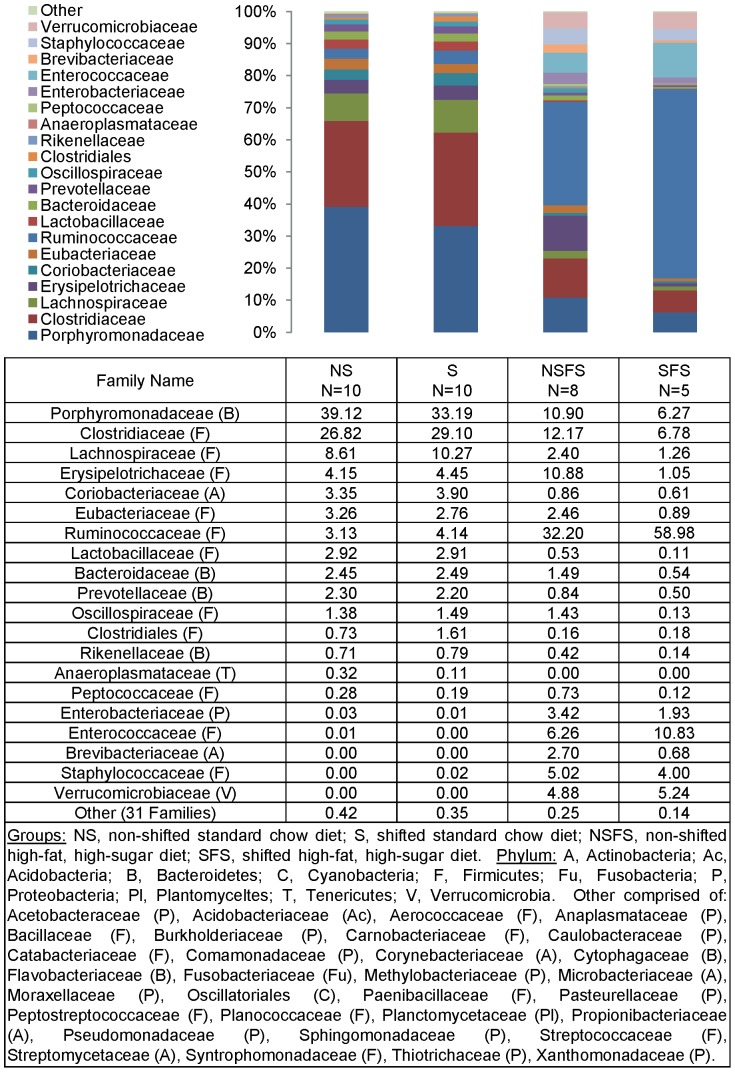
Mouse gut microbial community structure at the family level.The bar graph graphically represents the average relative abundance of classified bacteria SSU rRNA gene amplicons belonging to the most abundant taxon at the family level.